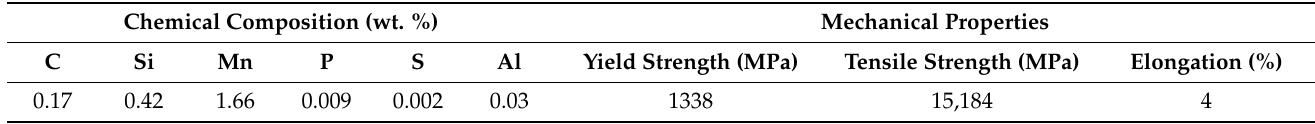
Table 1. The chemical composition and mechanical properties of the MS1400. Chemical Composition (wt.